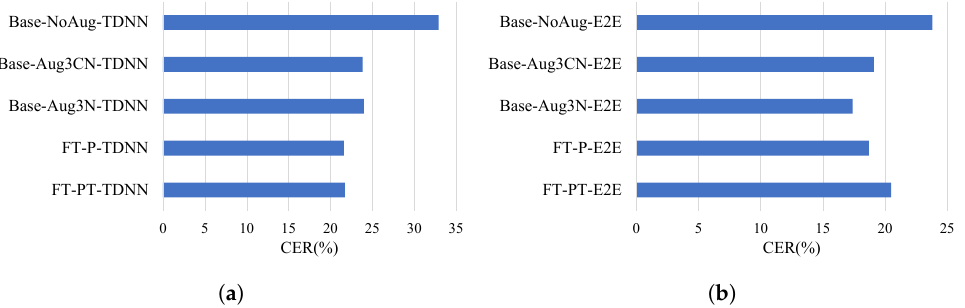
Figure 8. Performance of data augmentation on wireless pin mic speech in a classroom environment. ( a ) TDNN: domain adaptation for pin mic, ( b ) E2E: domain adaptation for pin mic Table 7. Wireless pin mic speech: character error rate (CER%) of different TDNN ASR models and character error reduction (CERR%) from Base-NoAug-TDNN. The notation “-” denotes “not applicable”. The expressions with bold font represent the models trained with proposed fine-tuning method. The bold numbers represent the best result for each test dataset.